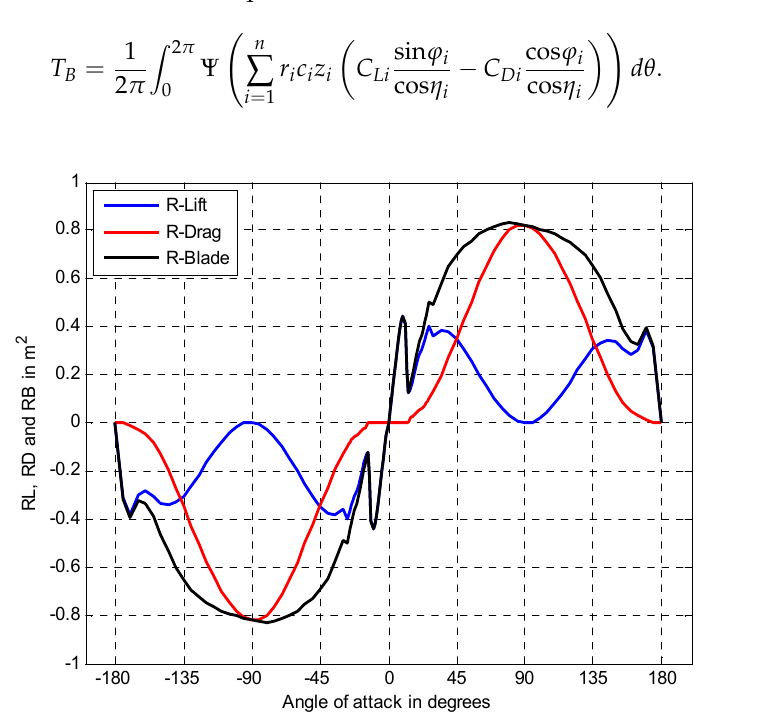
Figure 8. Lift, drag and normal resistance variations as functions of the angle of attack.